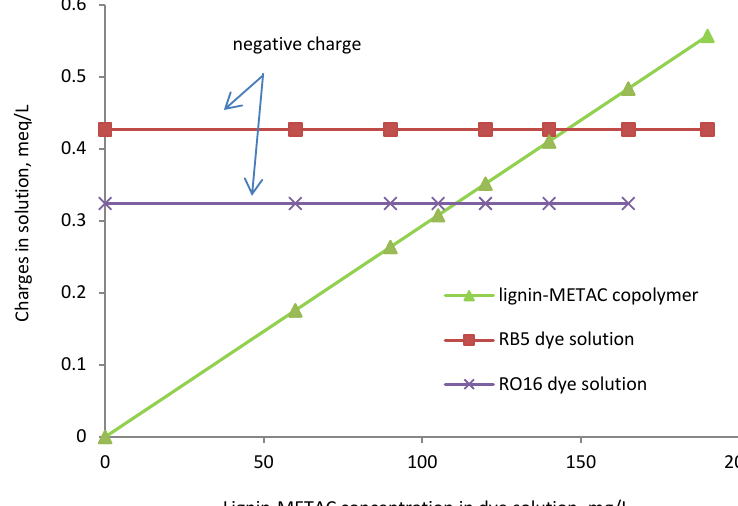
Figure 2. Overall cationic charges of the dye solutions (dye concentration, 100 mg/L) as function of lignin-METAC polymer (sample 4) concentration in the solutions.